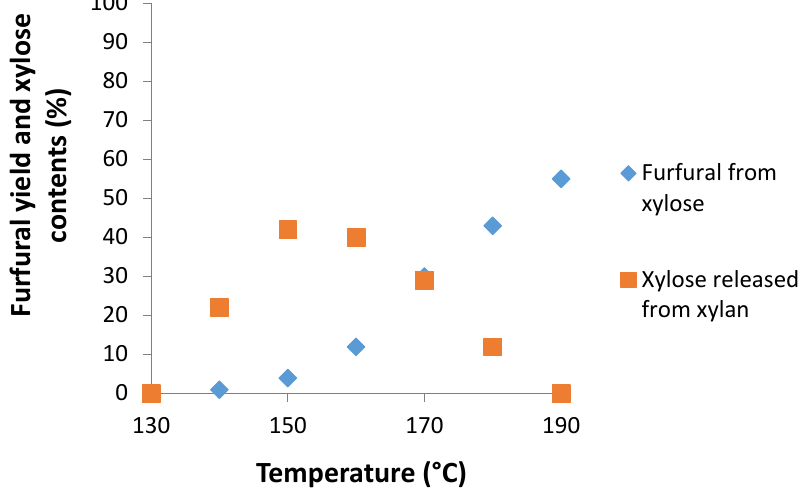
Figure 7. Furfural yield from xylan as a function of temperature for 60 min. Reaction conditions: Nafion NR50 (2 pellets), NaCl (95 mg), xylan (1.0 mmol), water (1 mL), CPME (3 mL), MW, 170 °C and 60 min.